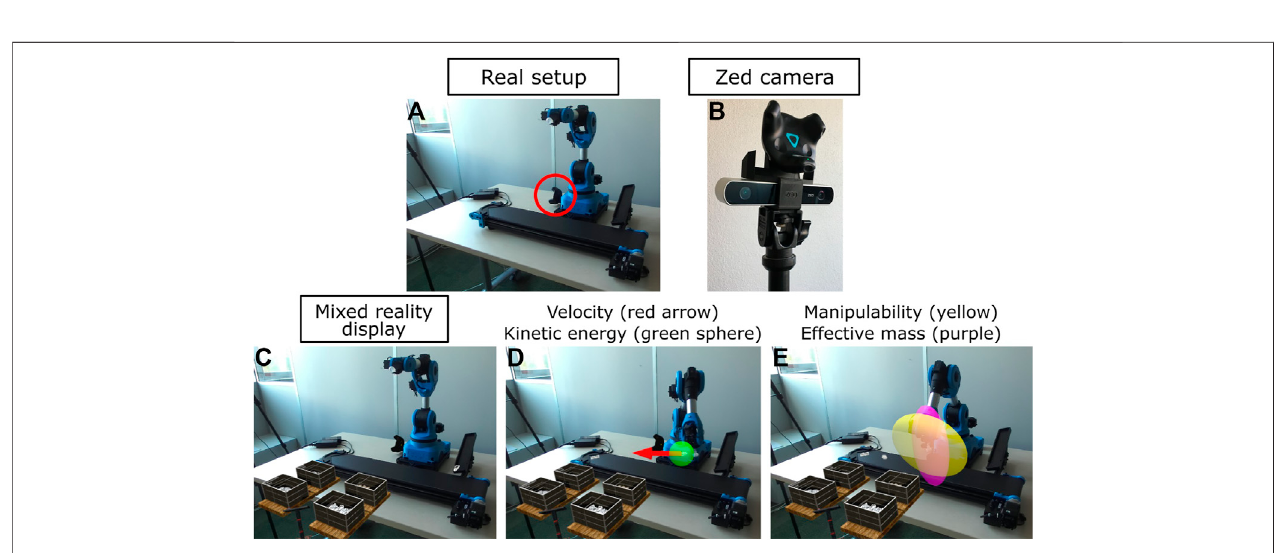
FIGURE 12 | A use case for education involving a real Niryo One robot and a real conveyor. The real setup (A) is augmented with virtual elements thanks to a Zed cameratrackedwithaHTCViveTracker (B) .Themixedrealitydisplay (C) showsvirtualparts topickand avirtualworkcell.Therobotvelocity andkineticenergy (D) ,and the manipulability and effective mass ellipsoids (E) are also